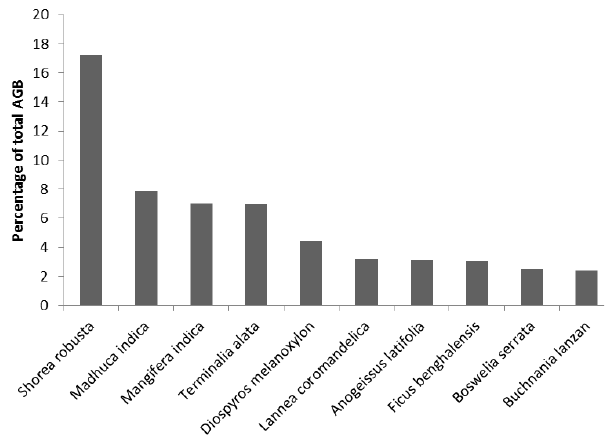
Fig. 3. Distribution of tropical forest trees in different diameter classes